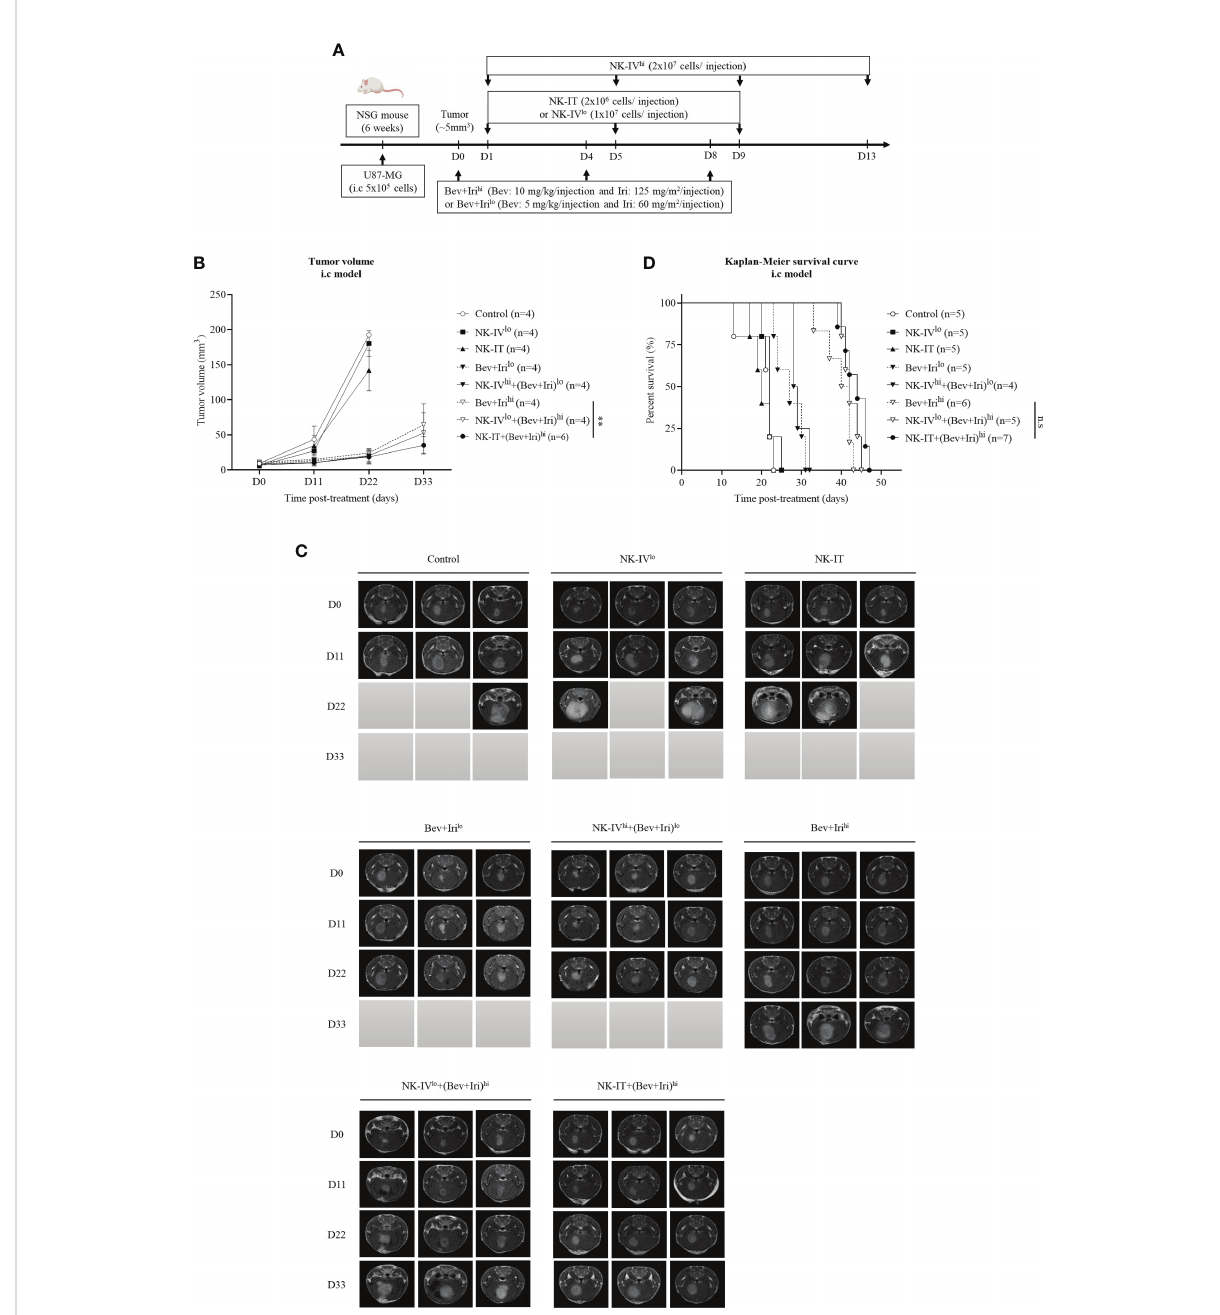
FIGURE 4 Experimental treatment schedule and therapeutic effects of NK-HD cells in combination with Bev plus Iri in the i.c U87 mouse model. At a tumor size of 5 mm 3 , the mice were treated with Bev and Iri every 4 days for 8 days. NK-HD cells were injected after 1 day of Bev and Iri treatment (A) . The tumor size before and after the treatment with NK-HD cells in combination with Bev plus Iri was clari fi ed every 6 days using MRI. The fi nal tumor volume was analyzed using the RadiAnt DICOM Viewer 2021.2.2 software and calculated as the summation of all tumor areas in each slide and multiplication by the slide thickness (B, C) . The Kaplan – Meier survival of U87-bearing mice after treatment with NK-HD cells in combination with Bev plus Iri was estimated. The statistical signi fi cance of survival was determined using a log-rank test with Bonferroni correction applied for comparisons (D) . NK-IV lo : intravenously injected NK-HD cells (1 × 10 7 NK cells); NK-IV hi : intravenously injected NK-HD cells (2 × 10 7 NK cells); Iri hi : intraperitoneally injected Iri (125 mg/m 2 ); Bev+Iri lo : intraperitoneally injected Bev (5 mg/kg) plus Iri (60 mg/m 2 ); Bev+Iri hi : intraperitoneally injected Bev (10 mg/kg) plus Iri (125 mg/m 2 ); NK-IT: intratumorally injected NK-HD cells (2 × 10 6 NK cells); U87: human GBM cell line. All data are shown as mean ± SD. p< 0.001 (**). n.s, no signi fi cant